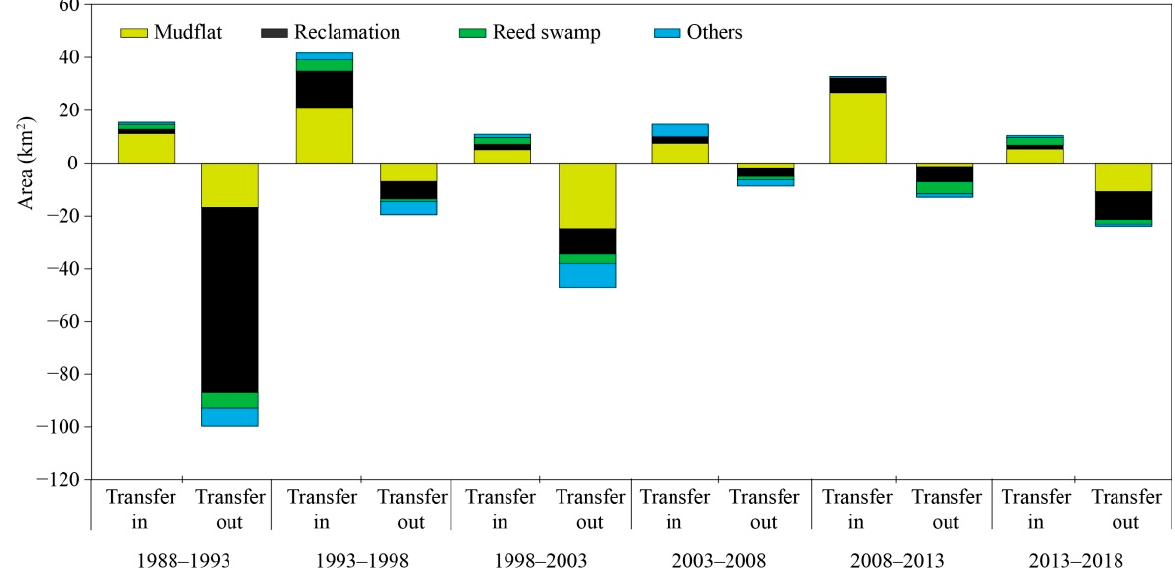
Figure 8. Land change between S. salsa saltmarsh area and other habitats near Liaodong Bay from 1988 to 2018.